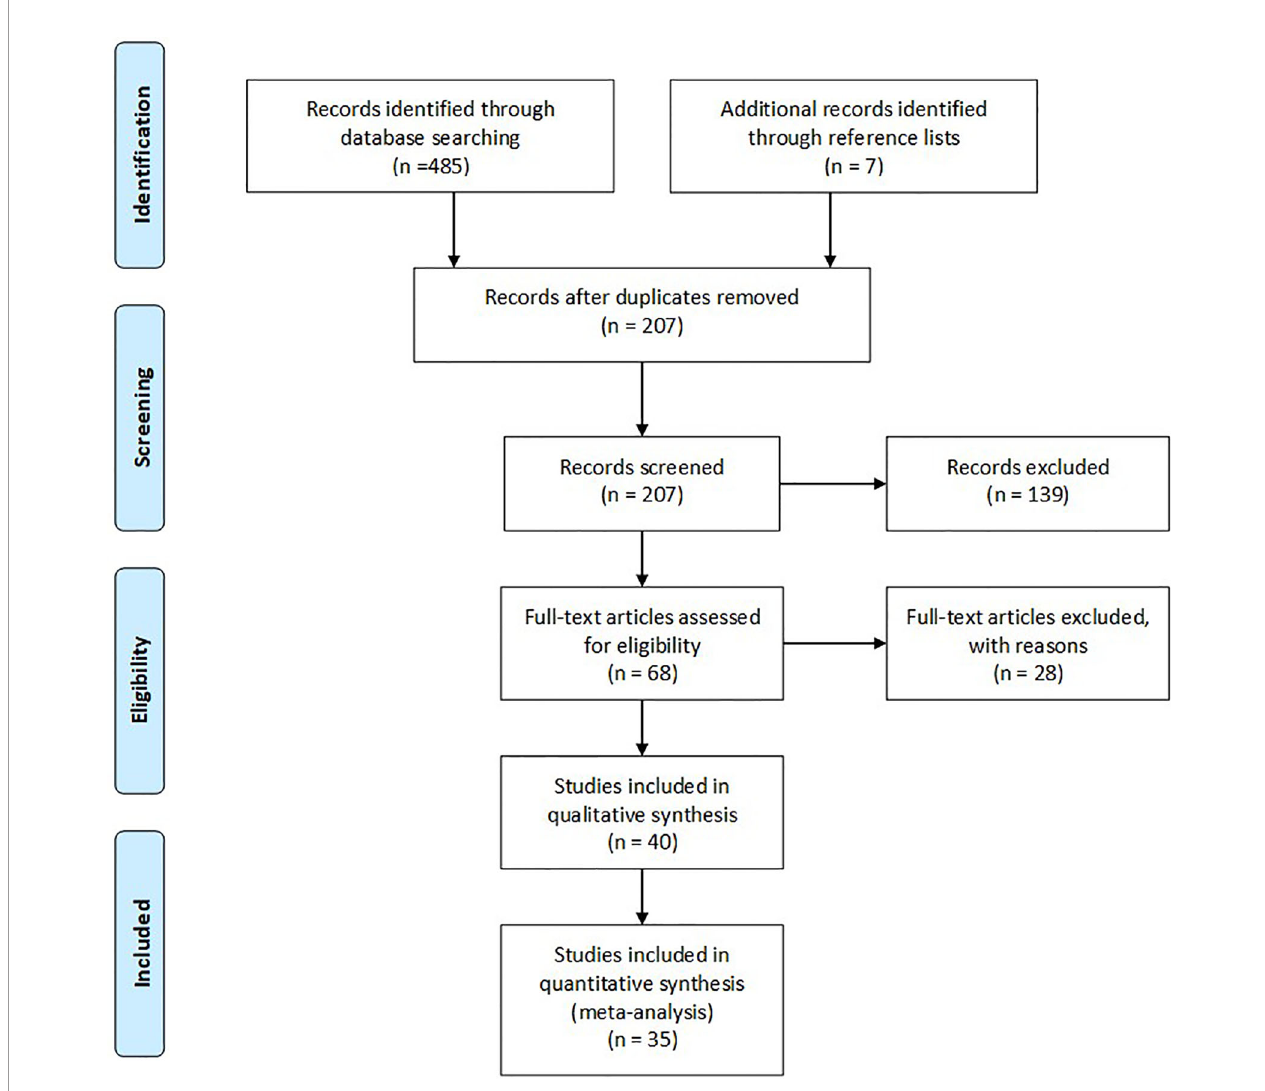
FIGURE 1 | PRISMA fl owchart of the included